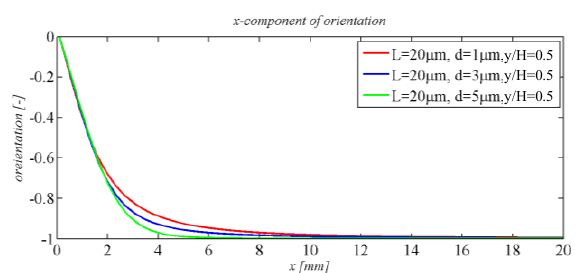
Fig. 9. Streamwise component of the orientation of fibre with L=20 µm and d p =1, 3 and 5